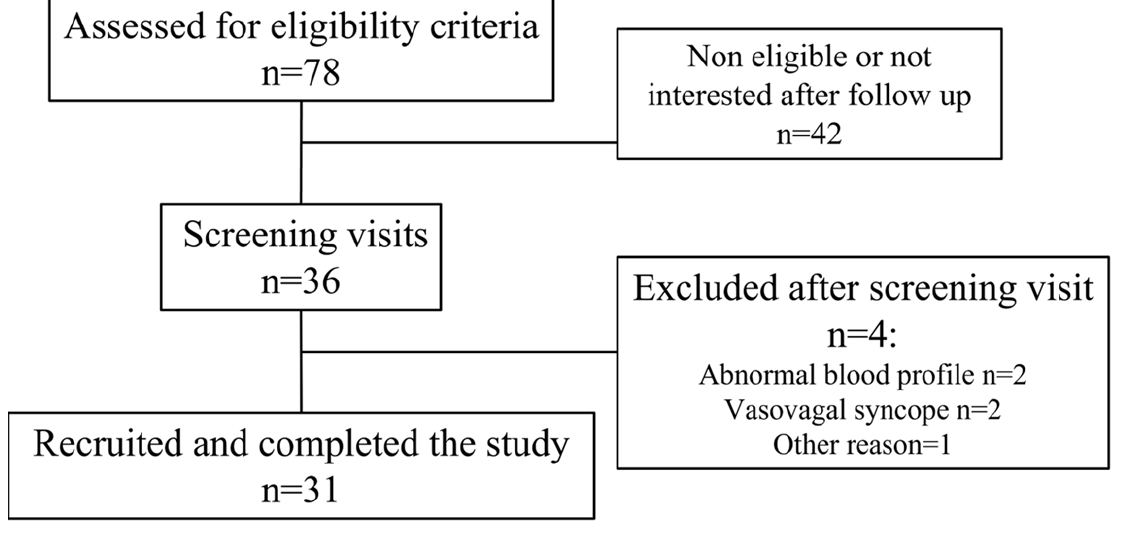
Figure 2. Flow chart of the study. Table 3. Anthropometric characteristics of the participants 1